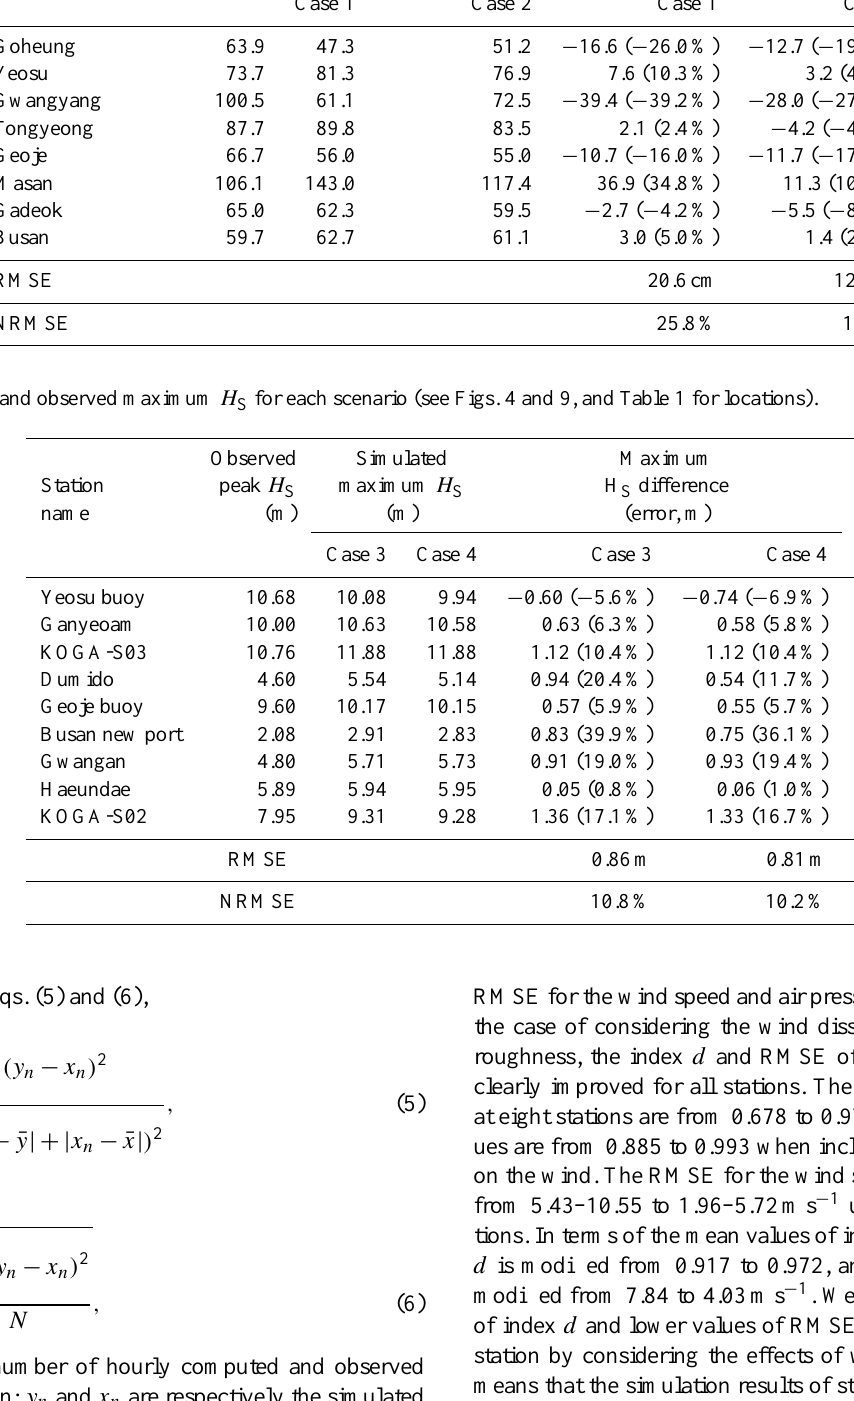
Table 4. The simulated and observed maximum storm surge heights for each scenario (see Figs. 4 and 9, and Table 1 for locations). Station